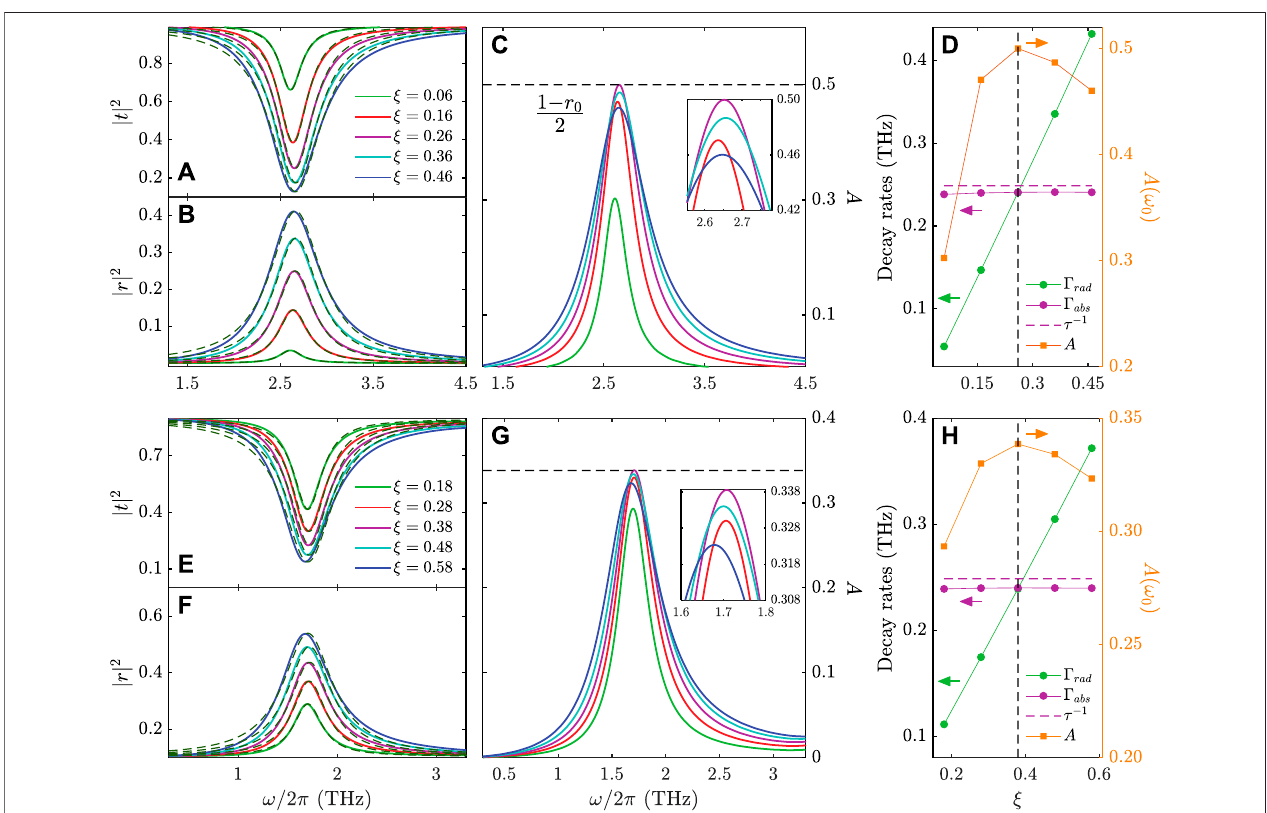
FIGURE2| THzwaveresponsesofGCWAwithdifferentdutyratios. (A – C) Numericalsimulationsoftransmission (A) ,re fl ection (B) ,andabsorption (C) spectrafor GCWA suspended in the air. (E – G) The corresponding transmission (E) , re fl ection (F) , and absorption (G) spectra for GCWA supported onto SiO 2 substrate. The gray dashedcurvesare fi ttingsusingtheQCMTmodel.Thedashedlinesin (C) and (G) arethetheoreticalmaximumabsorptioncalculatedby A max (cid:2) (1 − r 0 )/2.Theinsetsin (C) and (G) display the magni fi ed absorption spectra near the oscillation frequencies. (D, H) Radiative decay rate Γ rad and absorption decay rate Γ abs of GCWA suspended in the air (G) and supported onto SiO 2 substrate (H) . The decay ratesare obtained from fi tting the spectra shown in Figure (A, B) and (E, F) using the QCMT model. Absorption maxima, A ( ω 0 ), extracted at different oscillation frequencies are also included. Dashed black lines shown in (D) and (H) indicate the critical coupling